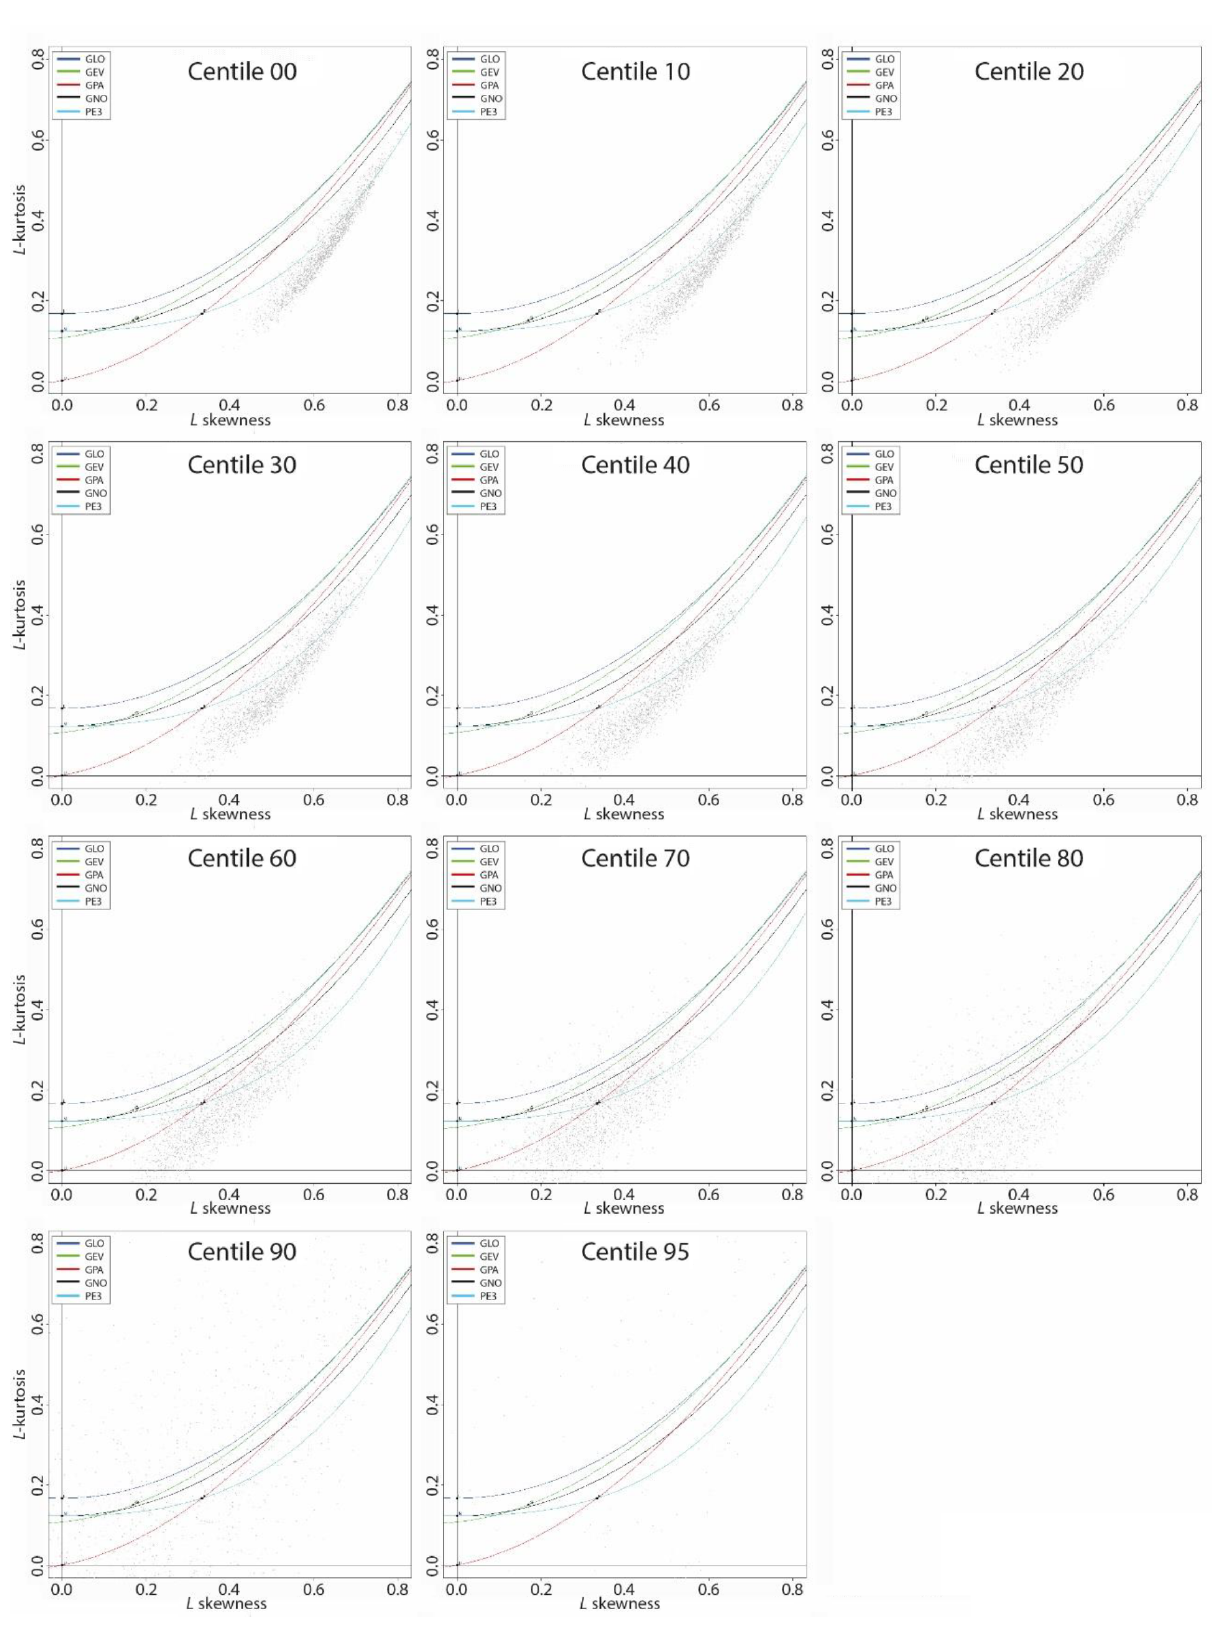
Figure 2. L-moment diagrams for the peak-over-threshold series obtained from the 12-month SPEI magnitude series. www.nat-hazards-earth-syst-sci.net/19/611/2019/ Nat. Hazards Earth Syst. Sci., 19, 611–628,